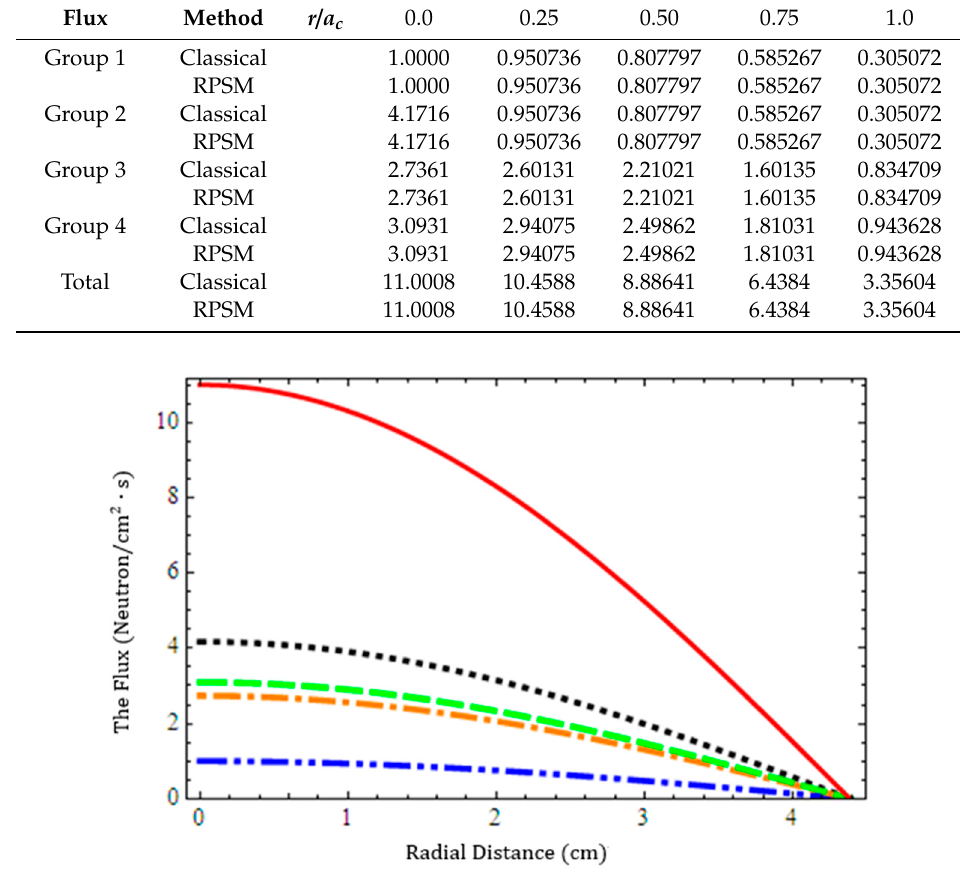
Figure 6. Four energy groups fluxes and total flux for a slab reactor. Dotted-dotted dashed line: ∅ 1 ( r ) , Dotted line: ∅ 2 ( r ) , Dotted dashed line: ∅ 3 ( r ) , Dashed line: ∅ 4 ( r ) , Solid line: Total fluxes.